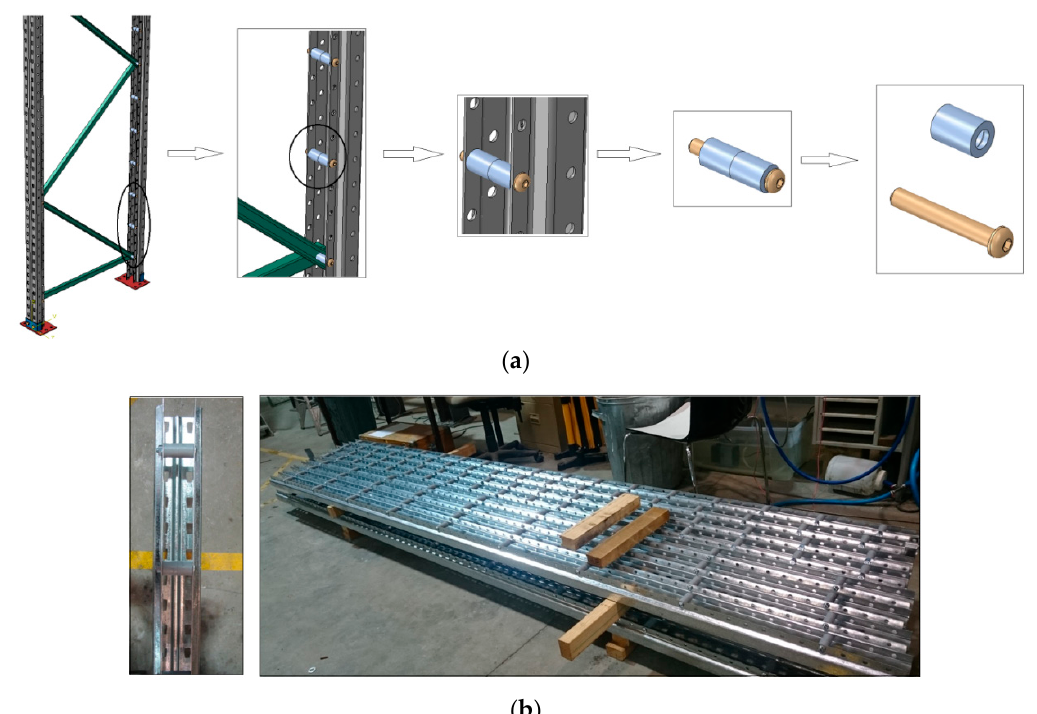
Figure 1. The reinforcement system and the constituent elements: ( a ) graphical section detail and ( b ) upright column in tests.